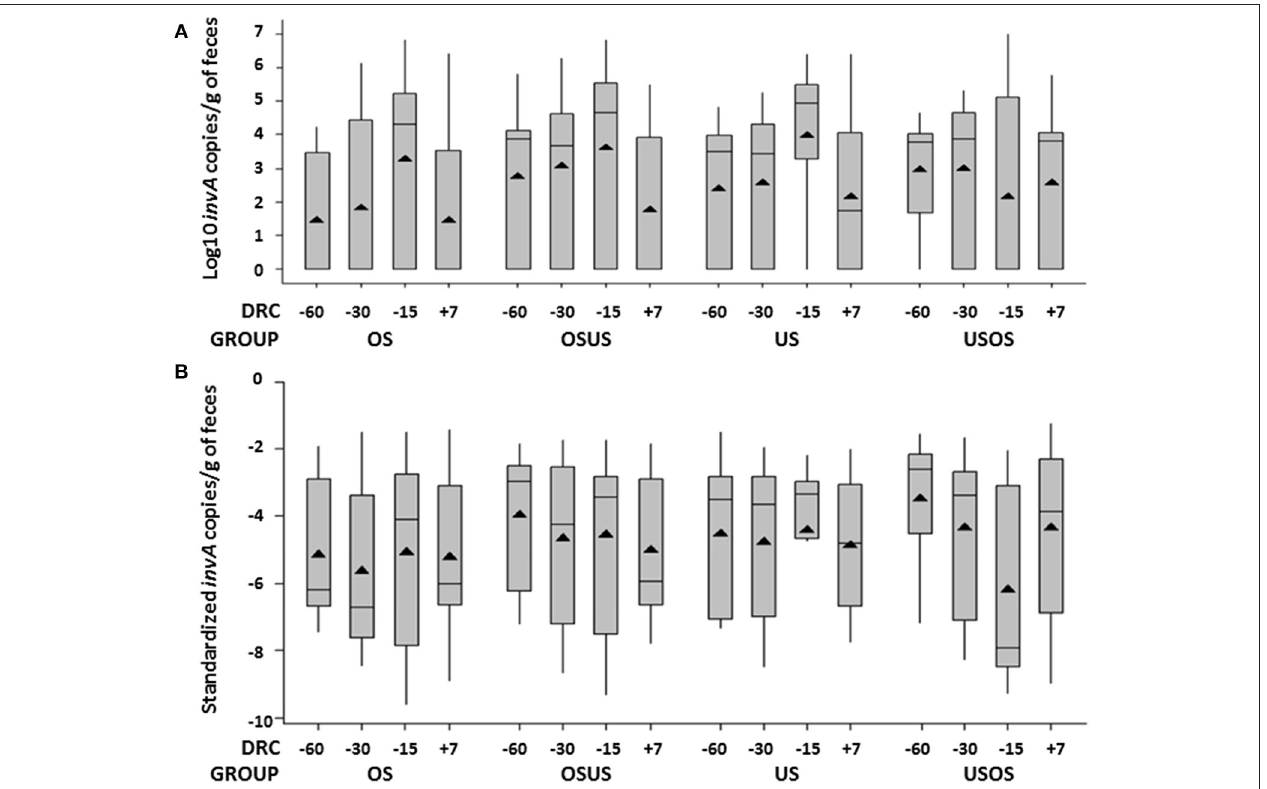
FIGURE 4 | Whisker box plot representing treatment group variations per days relative to calving (DRC) in (A) non-standardized, and (B) standardized fecal concentrations of Salmonella ( inv A gene). Mean (solid triangle), median (horizontal line), quartiles, and higher/lower observations are represented in each